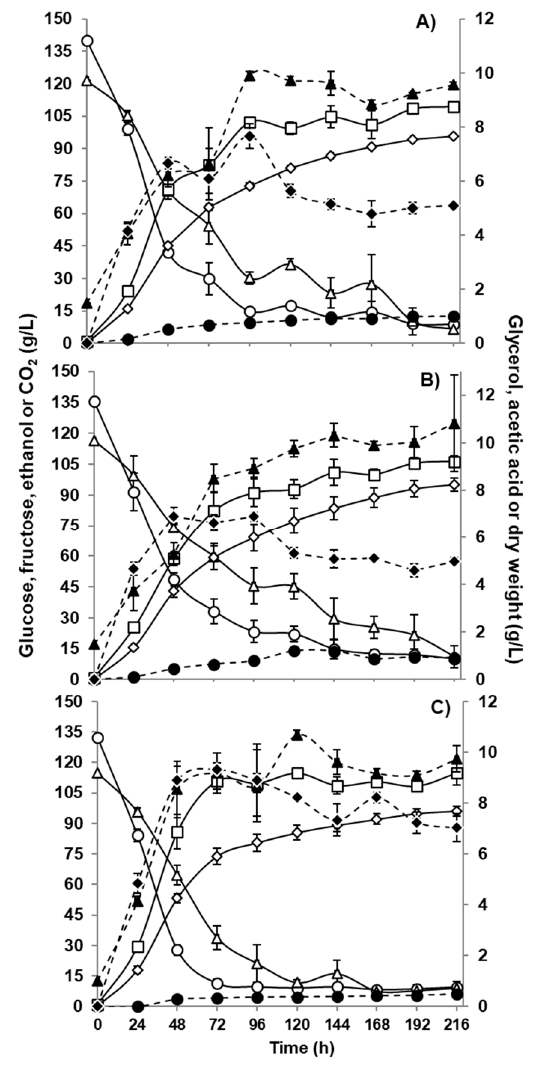
Figure 2. Fermentation kinetics on grape juice medium for the three Saccharomyces cerevisiae / Torulaspora delbrueckii (Td1AN9) mixed inoculum tested: ( A ) Sc3Y4/Td1AN9, ( B ) Sc3Y8/Td1AN9, and ( C ) Fermichamp/Td1AN9. Markers are average values of: ( − − ) Glucose, ( − − ) fructose, ( − − ) ethanol, ( − − ) CO 2 released, (- - - -) acetic acid, (- - - -) glycerol, and (- - - -) dry weight.